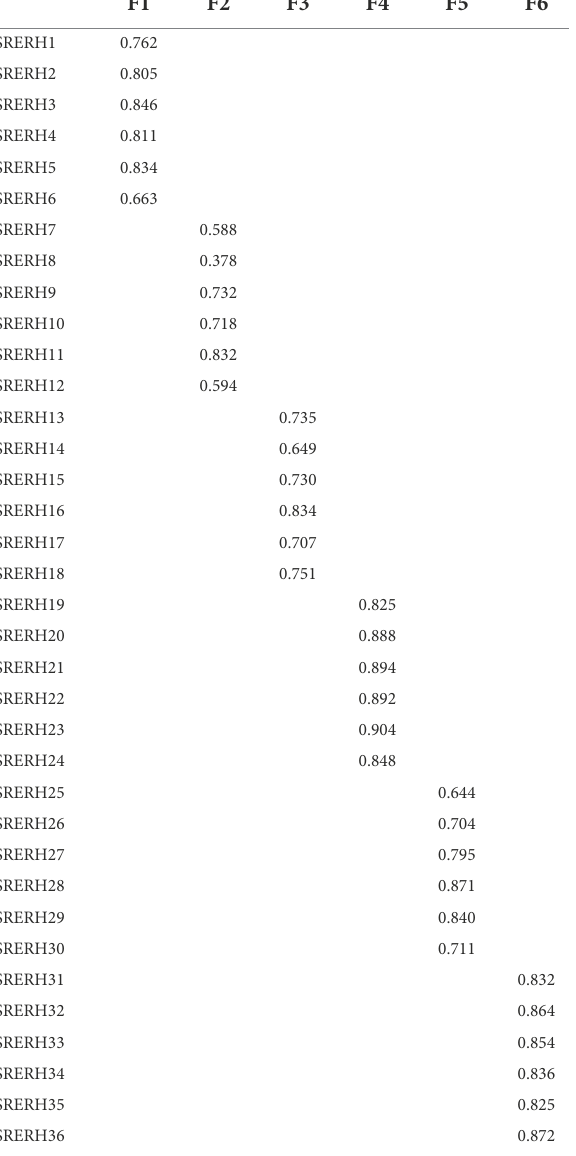
TABLE 18 Standardized total effects (default model; n =